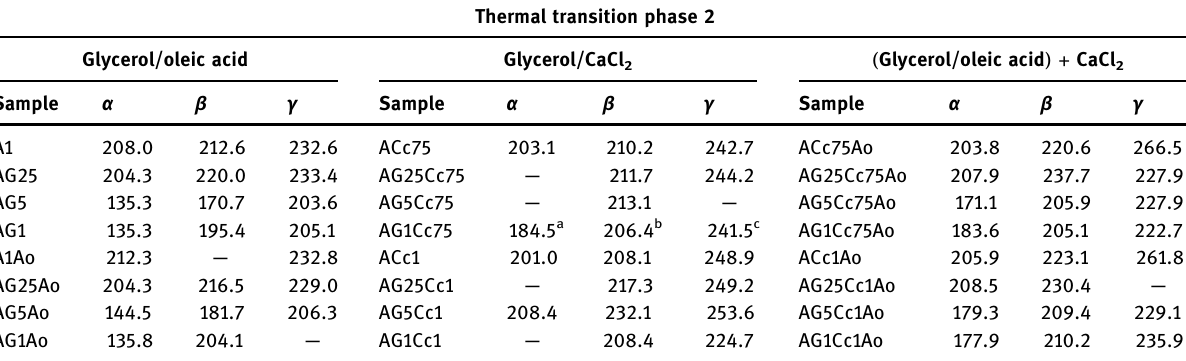
Table 4: Combined bands α , β , and γ . Endo - and exothermal transitions of bio fi lms depending on the components of glycerol/oleic acid/ calcium chloride